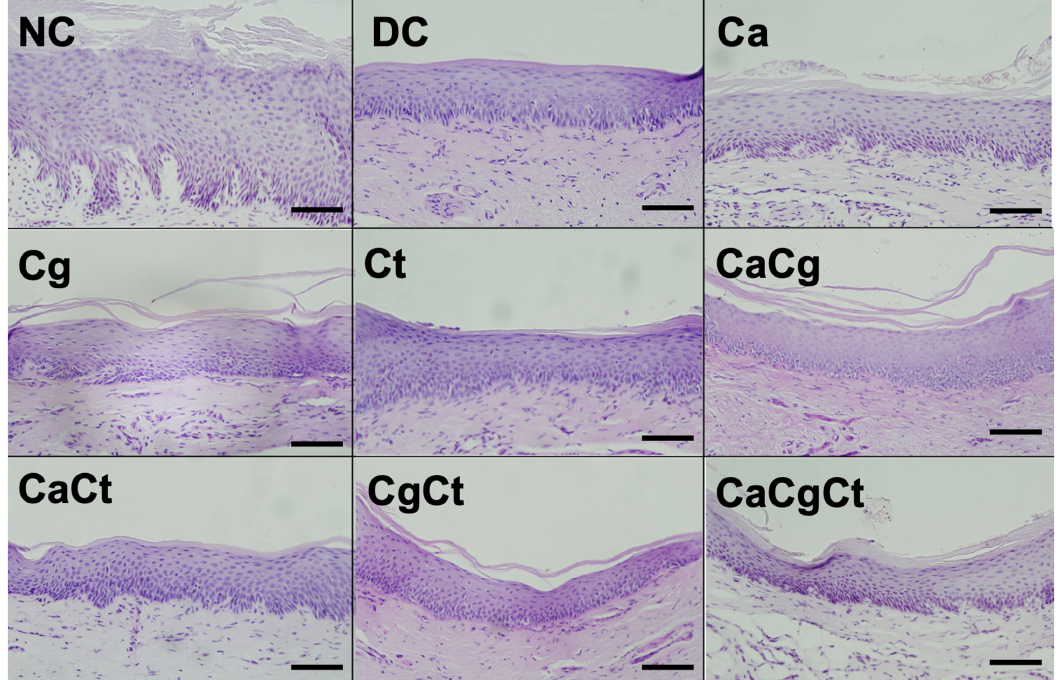
Figure 6. Histopathological sections of the palatal mucosa of female rats after the 4-week period with the acrylic device. NC: negative control. DC: device control, Ca: C. albicans , Cg: C. glabrata , Ct: C. tropicalis , CaCg: C. albicans + C. glabrata , CgCt: C. glabrata + C. tropicalis , CaCt: C. albicans + C. tropicalis , and CaCgCt: C. albicans + C. glabrata + C. tropicalis . Magnification: 20×. Scale bar: 100 μ m.